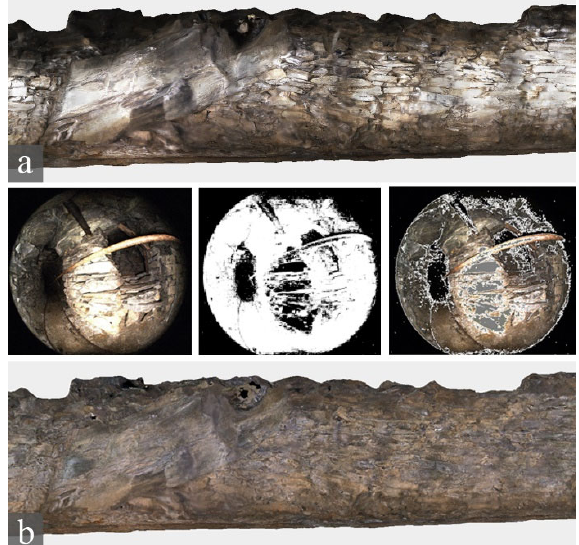
Figure 9. Images texture applied to the model: default outcomes (a), and result obtained after the images are masked (b). The central section shows an example image and the relative applied mask.